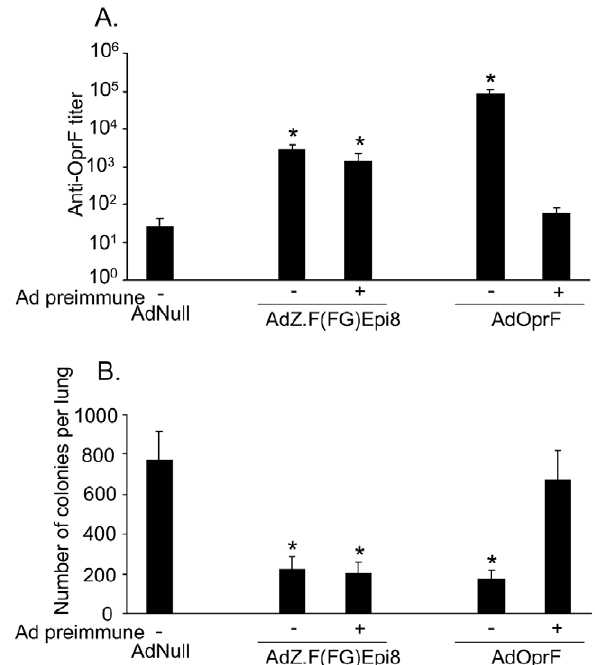
Figure 9. AdZ.F(FG)Epi8 induces robust humoral and protec- tive anti- P.aeruginosa in the presence of pre-existing anti-Ad immunity. BALB/c mice were immunized with AdZ.F(FG)Epi8, AdOprF or AdNull (all 10 10 pu)/mouse in the presence or absence of anti-Ad5 immunity. Mice were inoculated with 10 10 pu/mouse of AdNull and boosted twice at 2 weeks interval in order to mimic pre-existing immunity A. Anti-OprF IgG in serum determined by ELISA at 4 wk. Limit of detection is indicated by dotted line. * denotes p , 0.05, compared to AdNull-immunized mice. B. Protective immunity against pulmonary challenge with agar-encapsulated P. aeruginosa (4 6 10 6 cfu) 5 wk after immunization. Bacterial counts in lung homogenate were performed after 24 h. Data are shown as means 6 SEM of seven mice per group. * denotes p , 0.05, compared to AdNull-immunized mice.